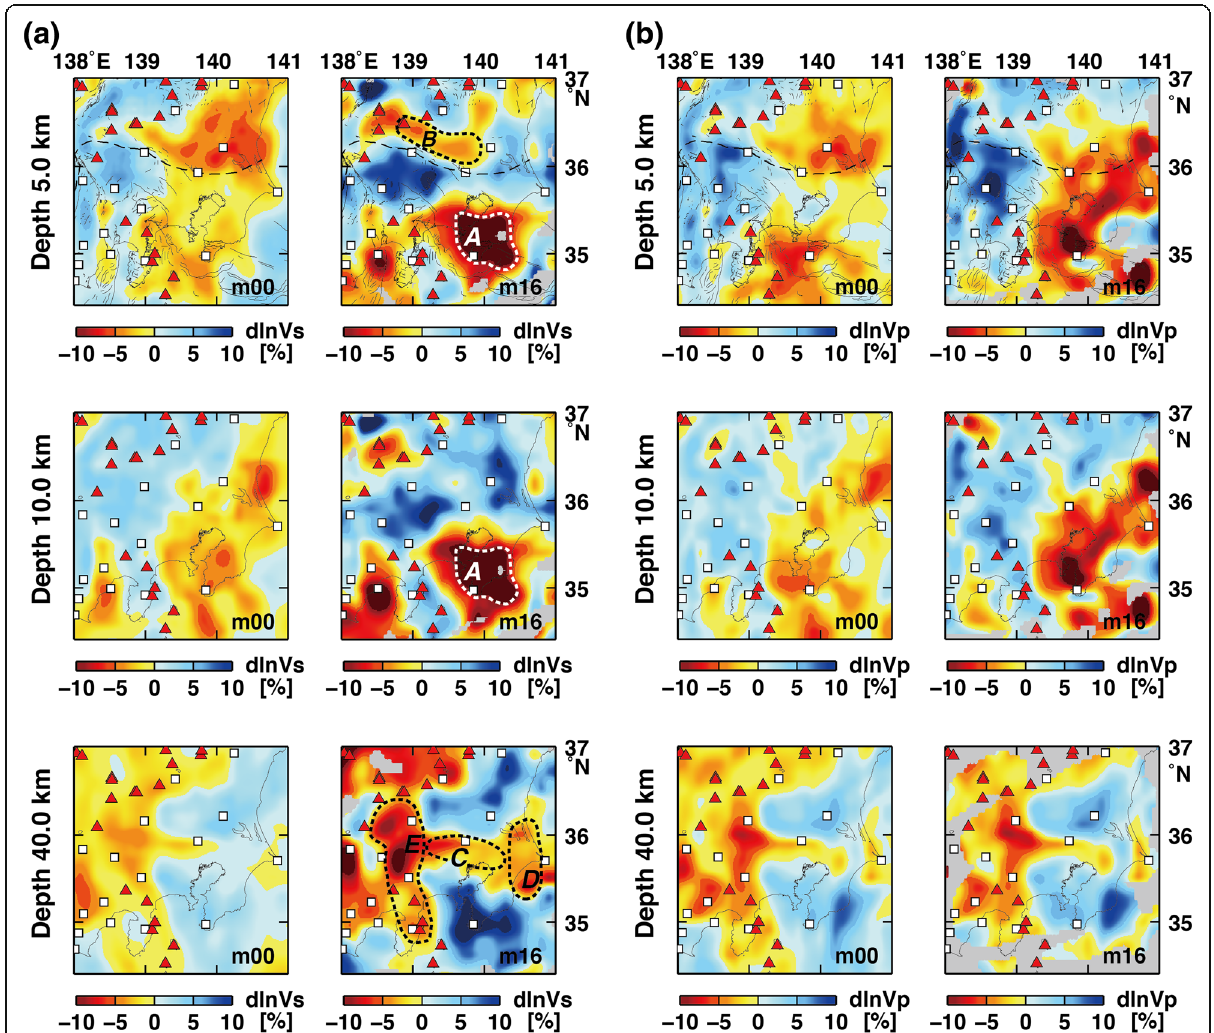
Fig. 12 Depth slices of the perturbation of the seismic wave speed from the average speed. a V s and b V p models. The left and right panels indicate the perturbations of the wave speeds for m 00 and m 16 , respectively. Areas labeled A to E in the right figures indicate low-wave